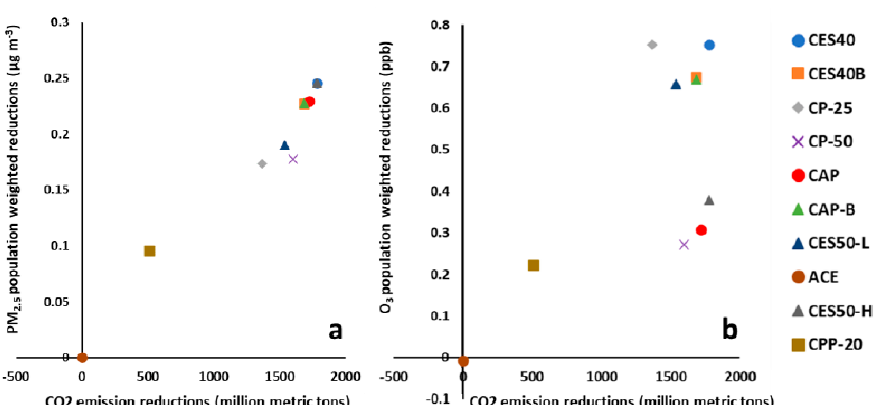
Figure 5. Population-weighted reductions in ( a ) PM 2.5 (in µ g m − 3 ), and ( b ) O 3 (ppb), between each policy and the BAU case for the year 2050, as a function of CO 2 reductions (in million metric tons).